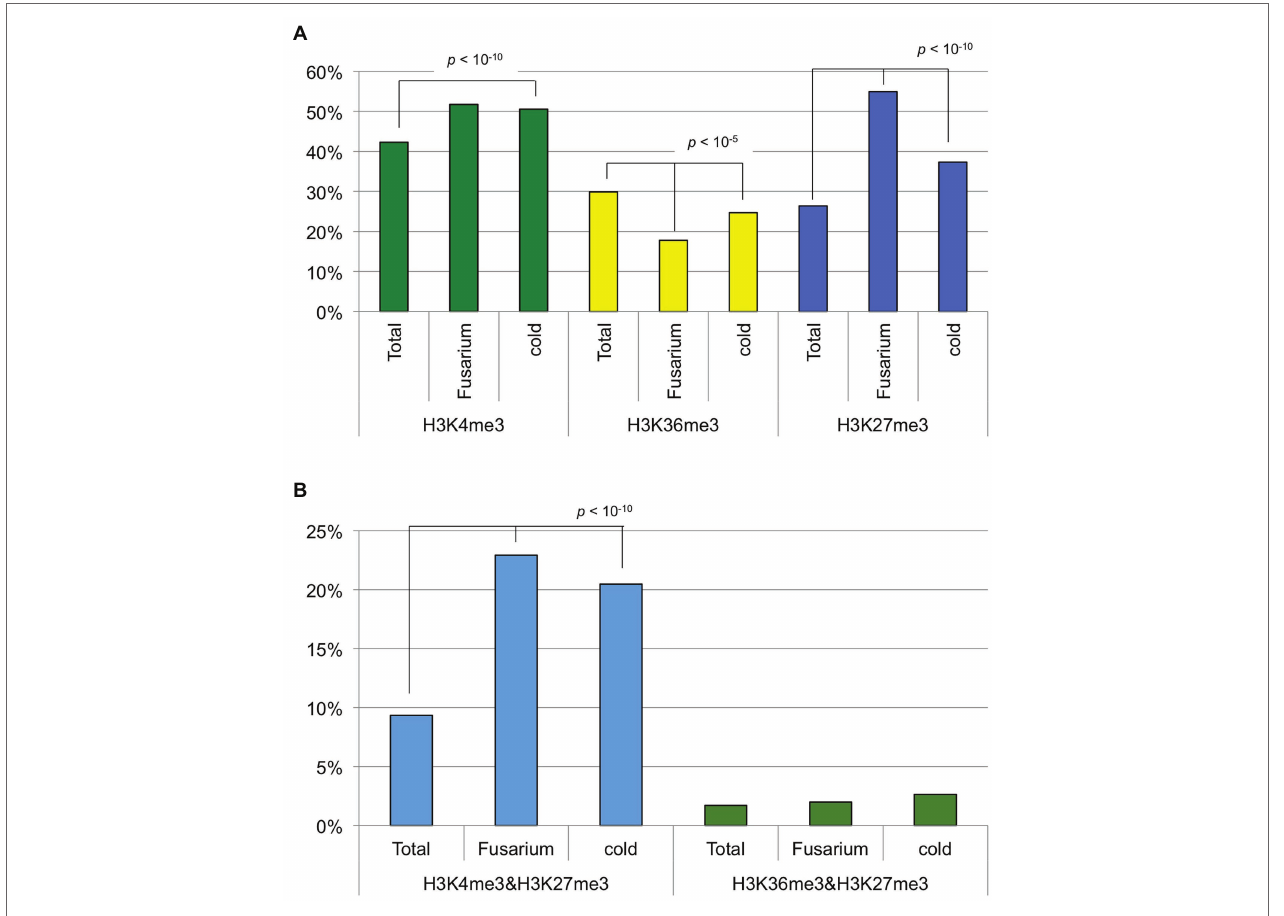
FIGURE 6 | The percentage of genes having histone modifications. (A) Genes having H3K4me3, H3K36me3, or H3K27me3 marks were used. (B) Genes having both H3K4me3 and H3K27me3 marks or both H3K36me3 and H3K27me3 marks were used. “Total” represents all the annotated genes in B. rapa . “Fusarium” and “cold” represent genes differentially expressed following Fusarium oxysporum f. sp. conglutinans inoculation and 4 weeks of cold treatment (vernalization),